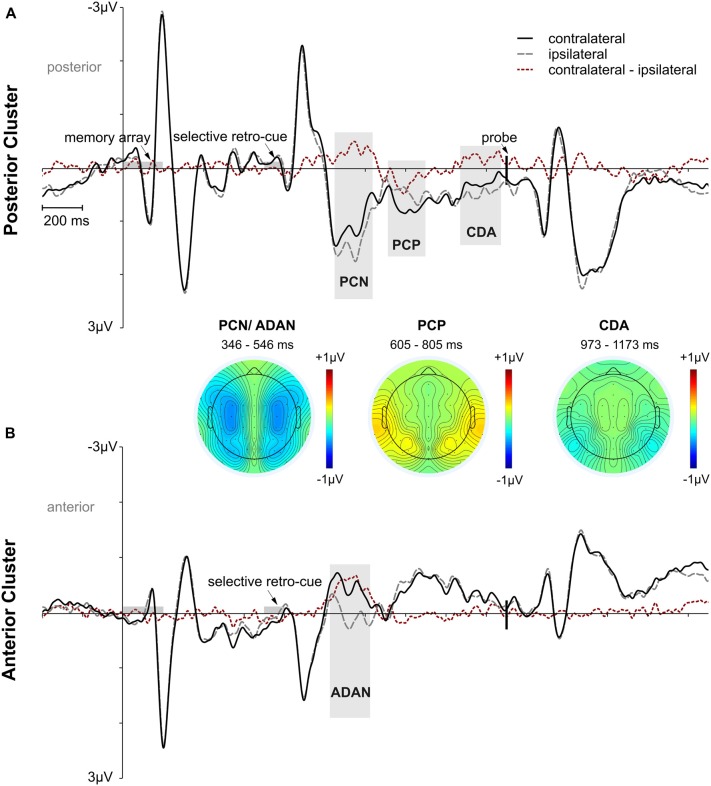
Overall event-related potential (ERP) effects time-locked to memory array onset for the posterior and anterior electrode clusters. Time intervals for memory array and retro-cue presentation are highlighted in gray. The vertical line marks the onset of the probe stimulus. Panel (A) shows posterior contralateral negativity (PCN), posterior contralateral positivity (PCP), and contralateral delay activity (CDA) effects for the selective retro-cue condition. Panel (B) depicts anterior directing attention negativity (ADAN) for the selective retro-cue condition. Additional topographies are depicted for the 200 ms analysis time windows centered on the mean FAL50 across participants. The PCN and ADAN effects are shown together in one topography. The red dotted lines reflect the contralateral minus ipsilateral difference waves.